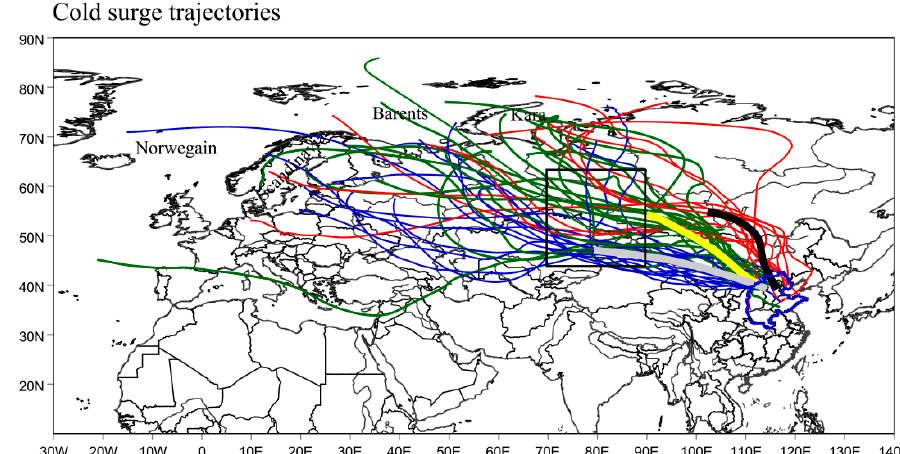
Figure 5. Six-day horizontal paths of autumn cold surges in North China from 1961 to 2014 and the corresponding classification: west path (blue lines), northwest path (green lines), and north path (red lines); gray, yellow, and black bold lines represent the synthesized trajectories formed 72 h before the onset of the cold surges. Black rectangles represent the key region (70–90° E, 43–65° N).